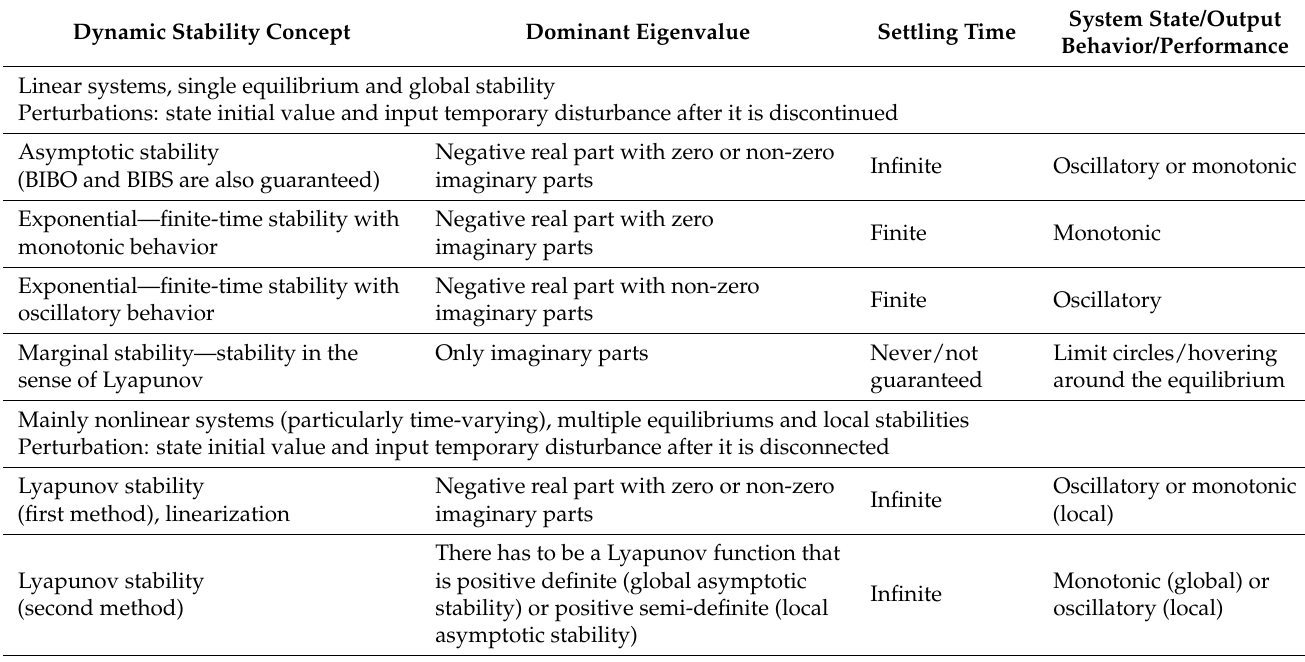
Table 3. Classification of dynamic stability concepts with a focus on the system